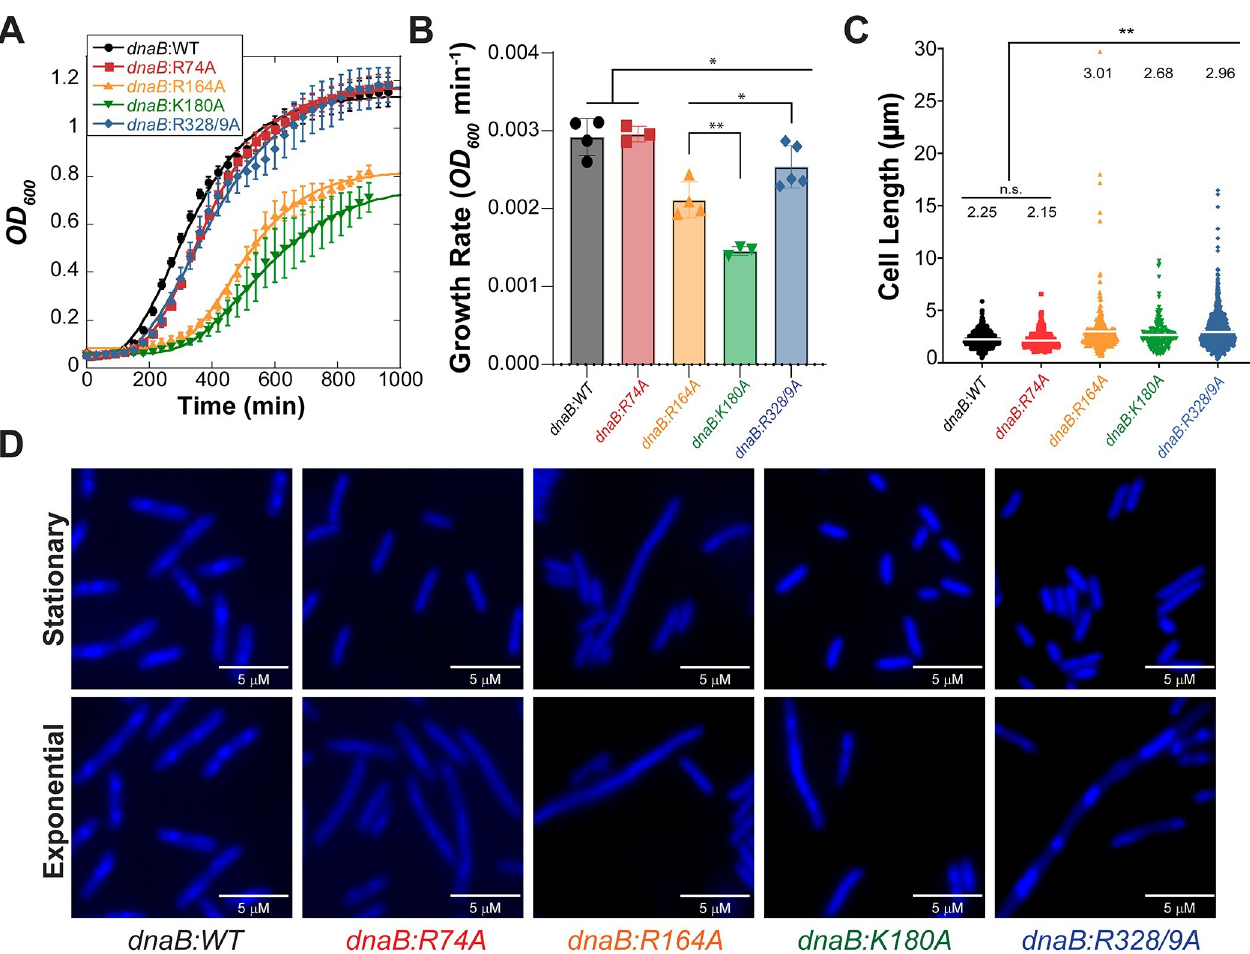
Fig 2. Growth and visualization of cell morphology of dnaB : mut and WT strains. ( A ) Growth curves of indicated E . coli strains grown at 32 o C are fitted to Eq 2 . Data plotted is the mean for three trials of three technical replicates each (n = 9), and error bars represent ± SD ( B ) The averaged absolute growth rate for each strain is plotted for comparison. Individual data is presented with open circles. Black bars indicate statistically significant differences, where p-values are � < 0.05 and �� < 0.01. ( C ) The cell lengths were measured by blinded visual quantification for n � 200 cells, and the average cell length is reported above the data points (grey bar) for each sample. Statistically significant differences are indicated, where p-values are �� < 0.01. n.s. is not significant. ( D ) Stationary and exponential growth cells are stained with DAPI and imaged using epifluorescence microscopy. Images shown are representative of the population observed. Wider views are provided in S4 Fig along with the quantification of stationary phase cell